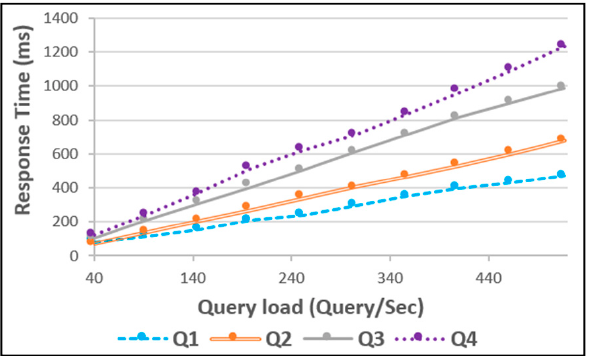
Figure 26. Query response time vs. input rate.